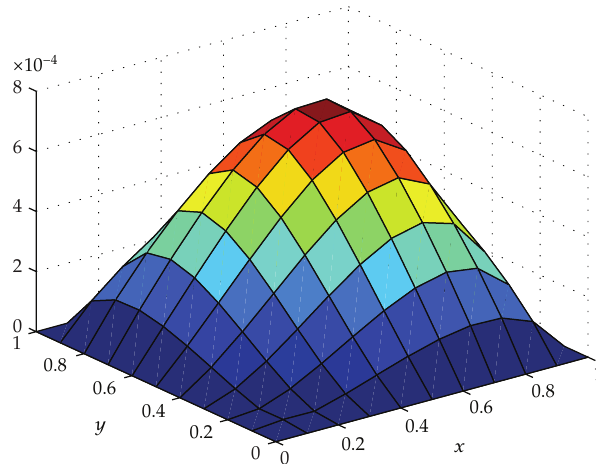
Figure 1: Absolute error at T (cid:9) 1, h (cid:9) 0 . 1, and Δ t (cid:9) 0 . 1.